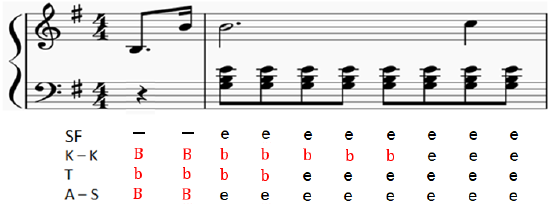
Figure 16. The music notation and key detection results obtained for the beginning of F. Chopin’s prelude No. 4, Op. 28, written in e-minor, where: SF is the method using the Signature of Fifths and K-K, T, and A-S are the strictly correlational approaches based on the Krumhansl–Kessler, Temperley and Albrecht–Shanahan key-profiles, respectively (incorrectly detected keys are marked in red).